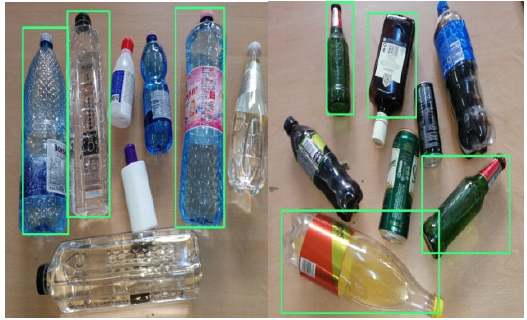
Figure 9. Inference detections for clutter scenario.